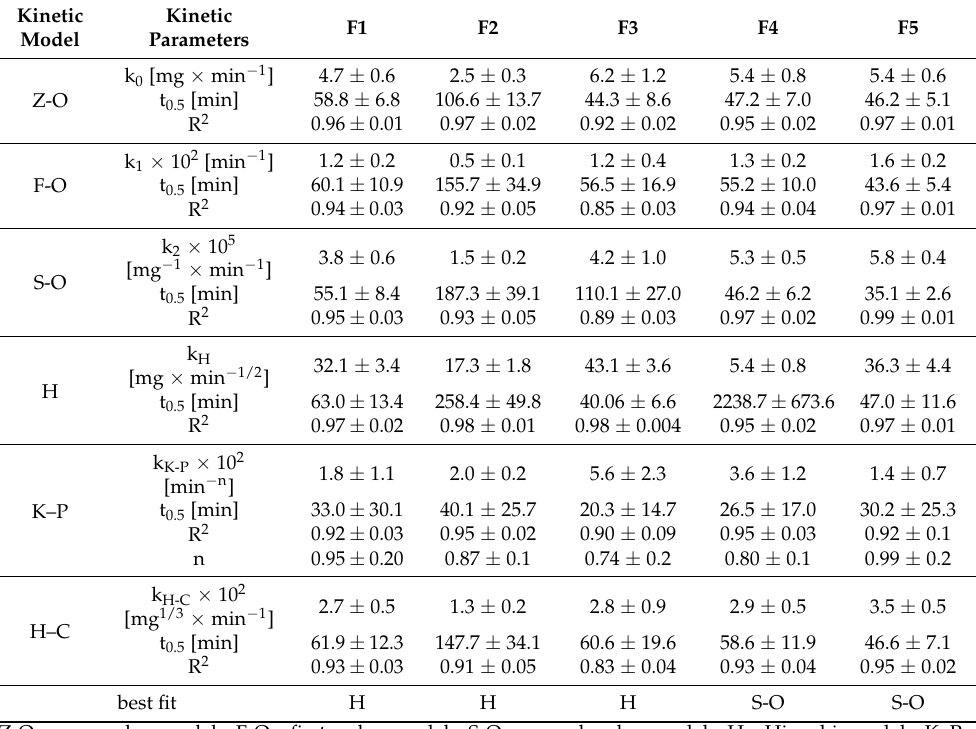
Table 2. The kinetic parameters of the first stage of the release of 5-ASA from F1–F5. Kinetic